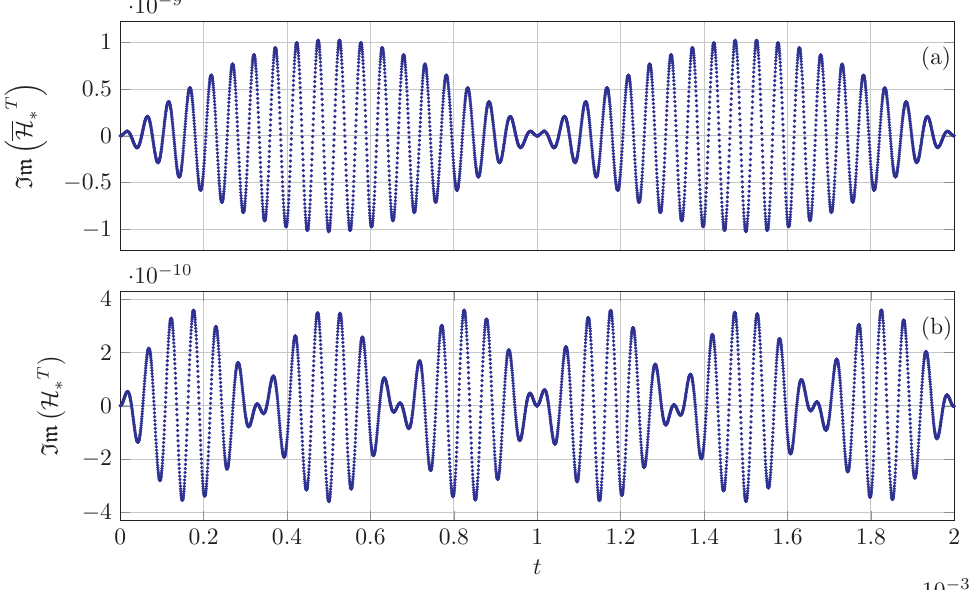
Figure 3. Generated tensorial coefficients pertaining to the magnetic part of the Weyl tensor on the perturbation length scale L = 10 − 5 L H using the background specified in Equation (163). The initial magnitude of the magnetic field on the background was chosen so that v A ( t 0 ) = 0.95. As for the initial perturbations, these were chosen according to Equations (174) and (175). In all calculations, = 2 k = 2 k ( t 0 ) / √ 5 and η ( t 0 ) = 10 − 12 . The plots show: ( a ) the imaginary part of the coefficient k ⊥ (cid:107) in the even sector; ( b ) The imaginary part of the coefficient in the odd